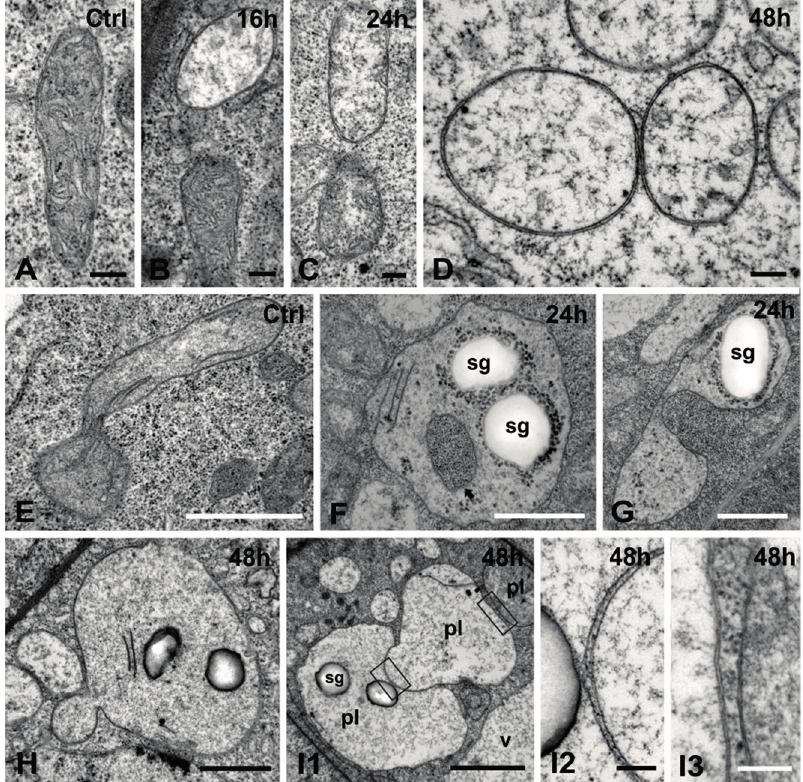
Figure 6. Cr(VI) effects to cytoplasmic organelles of A. thaliana . ( A – D ) Effects on mitochondria; ( A ) Control. A typical mitochondrion; ( B ) 16 h treatment. One translucent and one normal-looking mitochondrion; ( C ) 24 h treatment. Two mitochondria with translucent and almost translucent appearance; ( D ) 48 h treatment. Mitochondria with transparent stroma and delimited by intact double-membrane envelopes; ( E – K ) Cr(VI) effects to plastids; ( E ) Control. A phallus-like plastid bearing a few stroma thylakoids; ( F , G ) 24 h treatment; ( F ) An isodiametric plastid containing two starch grains (sg) surrounded by numerous electron dense granules, a few thylakoids (arrowheads) and a cytoplasmic invagination (arrow); ( G ) A saddle-shaped plastid bearing a starch grain (sg) and numerous electron dense granules, centrally engulfed by a deep cytoplasmic invagination; ( H ) 48 h treatment. A plastid having a bulbous expansion in the cytoplasm; ( I ) 48 h treatment. Three plastids (pl), the one intimately protruding toward the neighboring ( I1 ). Enlargements of the areas outlined in I1, showing single membranes at the bulging outgrowth ( I2 ) and double membrane envelopes of the neighboring plastids ( I3 ). v, vacuole. Scale bars: ( A – D , I2 , I3 ): 0.2 μ m; ( E – I1 ): 1 μ